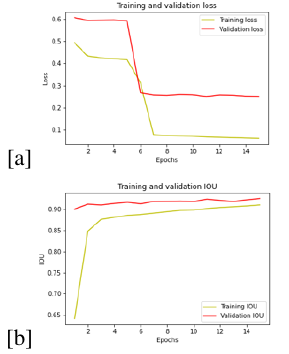
Figure 4. (a) shows the progression of training and validation loss and (b) shows the progression of training and validation IoU, for the Unet model with Efficient B7 as encoder, over 15 epochs.